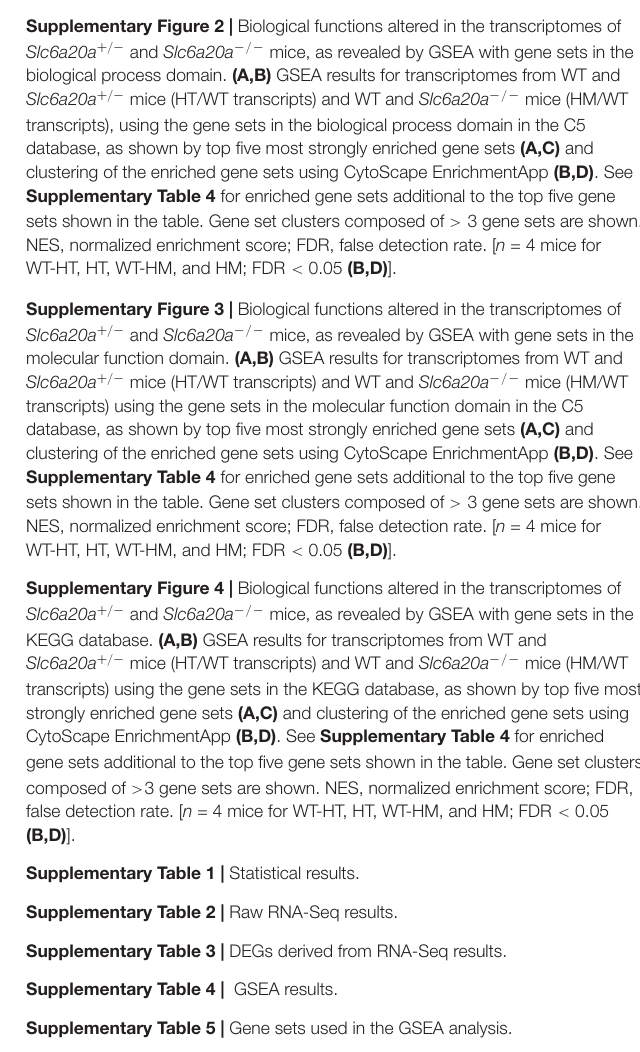
Supplementary Table 1 | Statistical results. Supplementary Table 2 | Raw RNA-Seq results. Supplementary Table 3 | DEGs derived from RNA-Seq results. Supplementary Table 4 | GSEA results. Supplementary Table 5 | Gene sets used in the GSEA